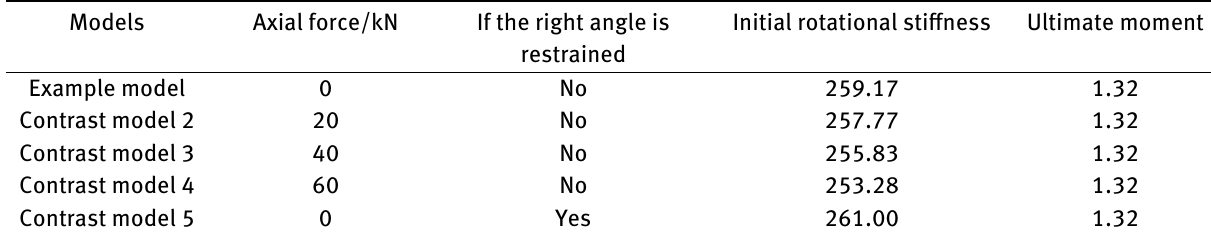
Table 1: Calculation results of comparison models